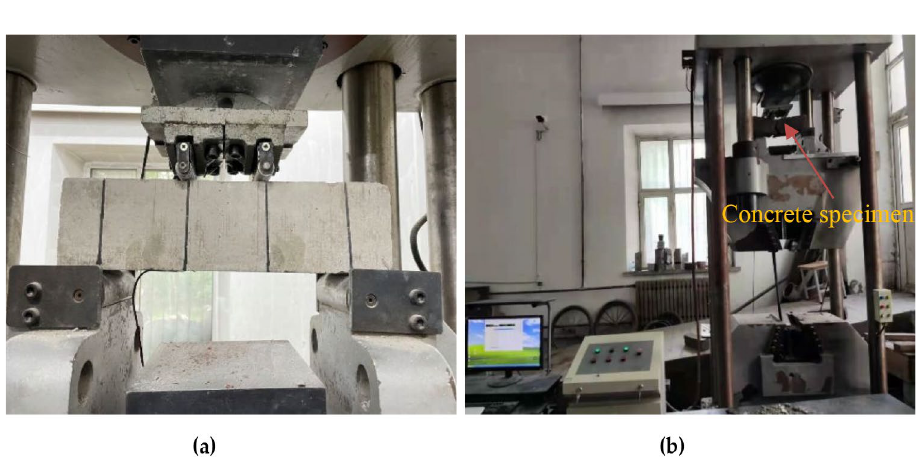
Figure 5. Prismatic specimen flexural test: ( a ) Prismatic flexural strength test (close up); ( b ) Prismatic flexural strength test